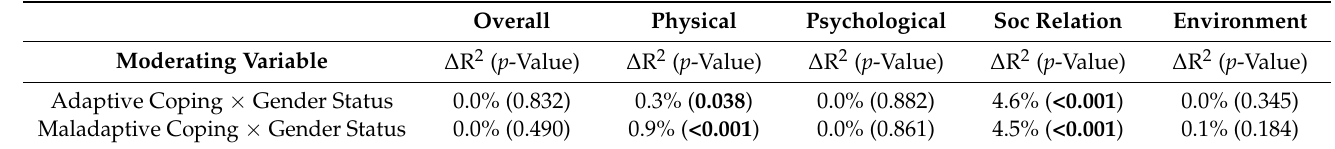
Table 5. Test of coping style as a moderating variable between gender status and QoL in the overall sample. Overall Physical Psychological Soc Relation Environment Moderating